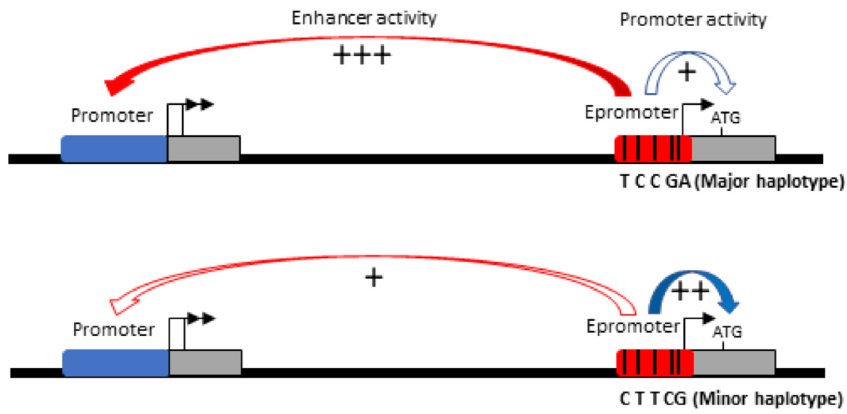
Figure 9. A model for transcriptional regulation of ATP2B4 gene. The newly identified region containing the five SNPs studied (rs11240734, rs1541252, rs1541253, rs1541254, and rs1541255) corresponds to an alternative promoter with an enhancer function. Its activity is modulated by the combination of SNPs. The major haplotype had a stronger enhancer effect on the main ATP2B4 promoter, increasing transcription of long transcripts, whereas the minor allele haplotype had stronger promoter activity, resulting in an increase in short transcripts.